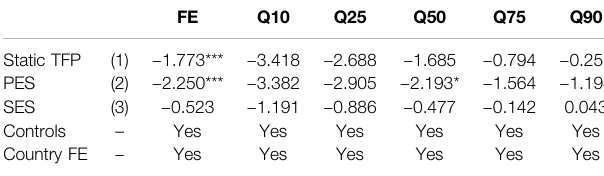
TABLE 5 | Robustness test for static